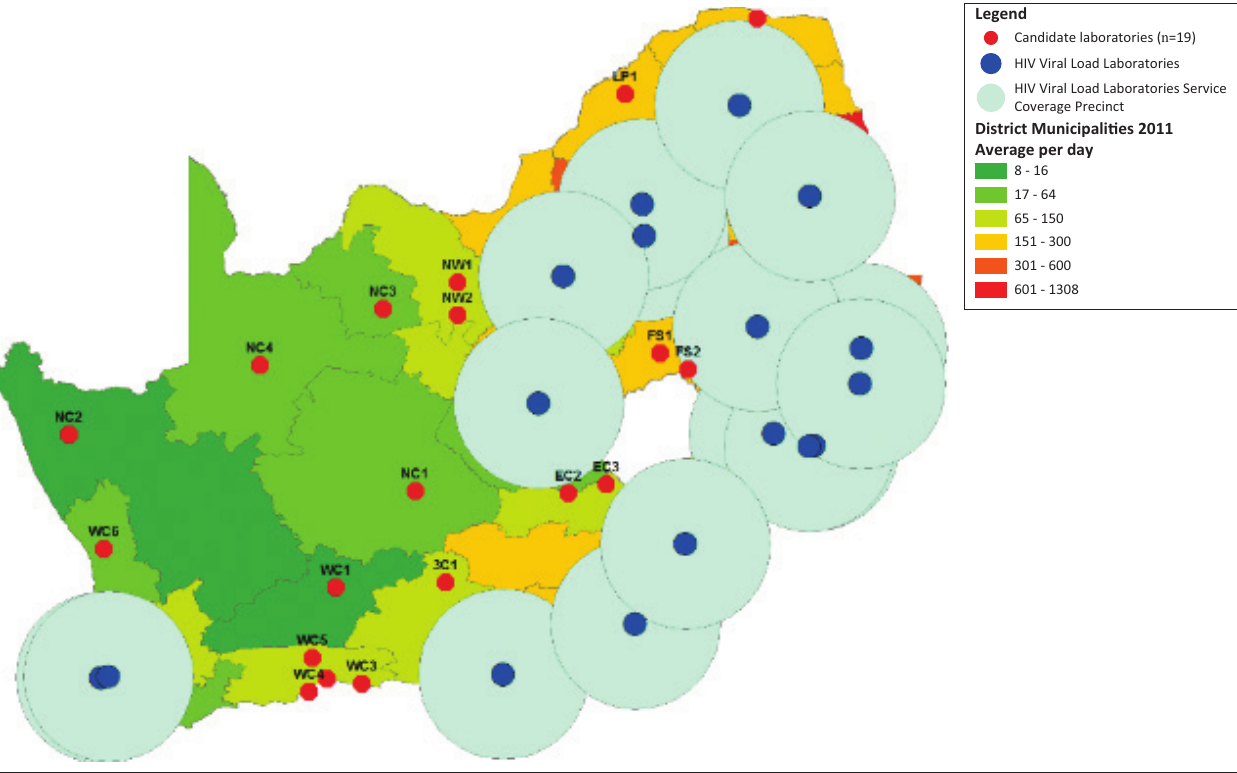
FIGURE 3: Current HIV viral load coverage provided using a service coverage precinct of 150 km circumference and the identification of candidate laboratories in the coverage gaps ( n = 19), South